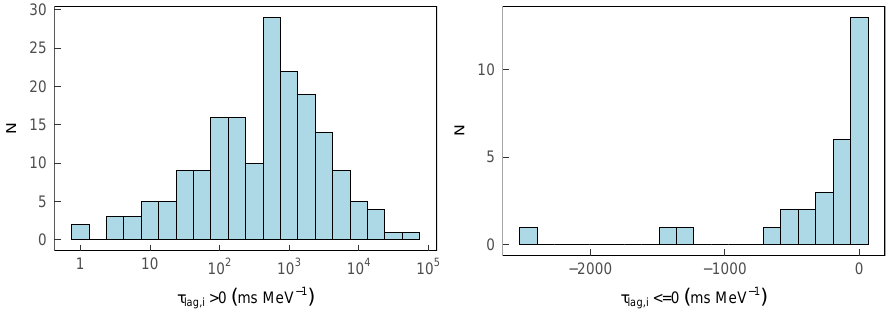
Figure 15. The distribution of rest frame spectral time lag τ lag,i . The left panel shows the GRBs with positive values in logarithmic scale. The right panel shows the ones with negative values in normal